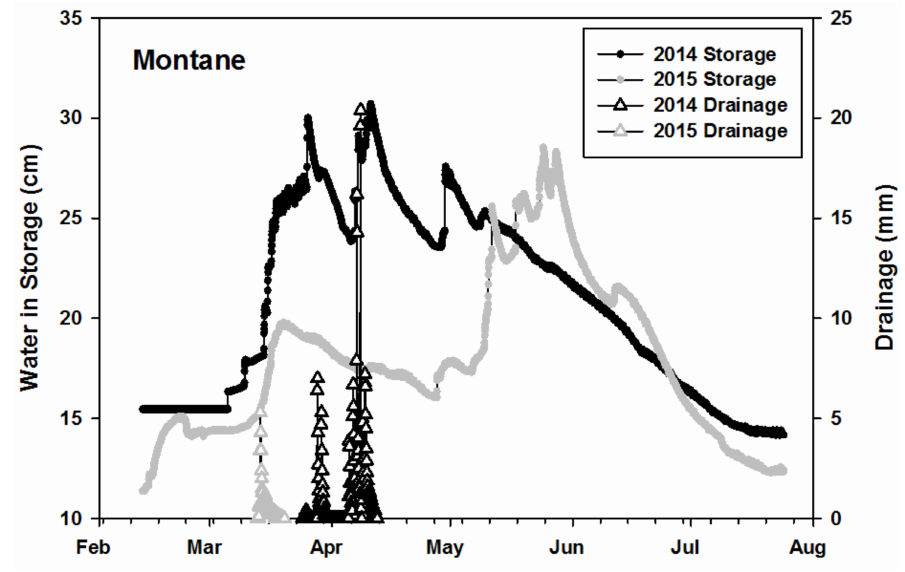
Figure 4. Soil water storage and drainage volume at the Montane West site for 2014 and